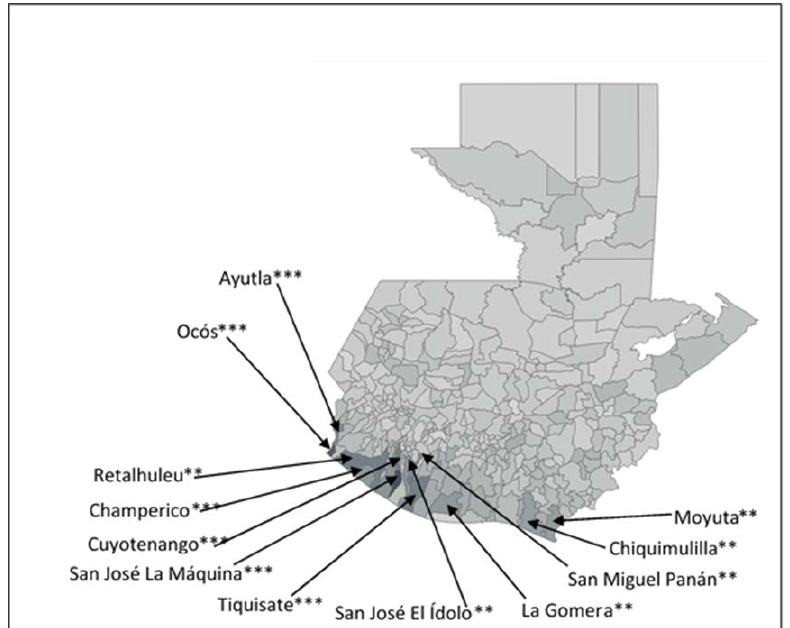
Figure 3. Municipalities that are part of the top 25 municipalities with highest CKD mortality rates all six age- or sex-specific groups ***, and in five age- or sex-specific groups **. Bivariate analysis showed very strong positive and negative associations for some of the Institute of Agriculture, Natural Resources and Environment of the Rafael Landívar University’s (IARNA) agrarian territories (Table 4). For the under-20 population, the only significant association was with the “5. East” agrarian territory (regression coefficient 5.31, p < 0.05). For the other five groups, there were very highly significant positive associations ( p < 0.01) with the agrarian territories “4. Concentrated in the south and dispersed in the highlands” (regression coefficients between 23.06 for under 45 population, and 47.37 for male population) and “7. Southwest” (regression coefficients between 22.20 for female population, and 81.16 for male population); there were very highly significant negative associations ( p < 0.01) with the agrarian territory “2. North transversal strip” (regression coefficients between − 21.11 in under 45 population and − 52.28 in male population) and with the agrarian territory “1. Northwest highlands” (regression coefficients between − 11.98 in under 45 population and − 36.79 in male population); and highly significant negative associations ( p < 0.05) with the agrarian territory “8. Petén” (regression coefficients between − 22.78 in under 45 population and − 56.09 in male population). Table 4. Bivariate linear regression coefficients for agrarian territories and municipal mortality rates for chronic kidney disease, by gender and age group, Guatemala 2009–2019 ( N = 28,723). Female Popula- Male Popula- Popula- Popula- Agrarian Territo- Popula- tion of all Population, tion under tion under tion under ries tion, all Ages all Ages 60 Years 45 Years 20 Years Ages − 26.64 *** lands